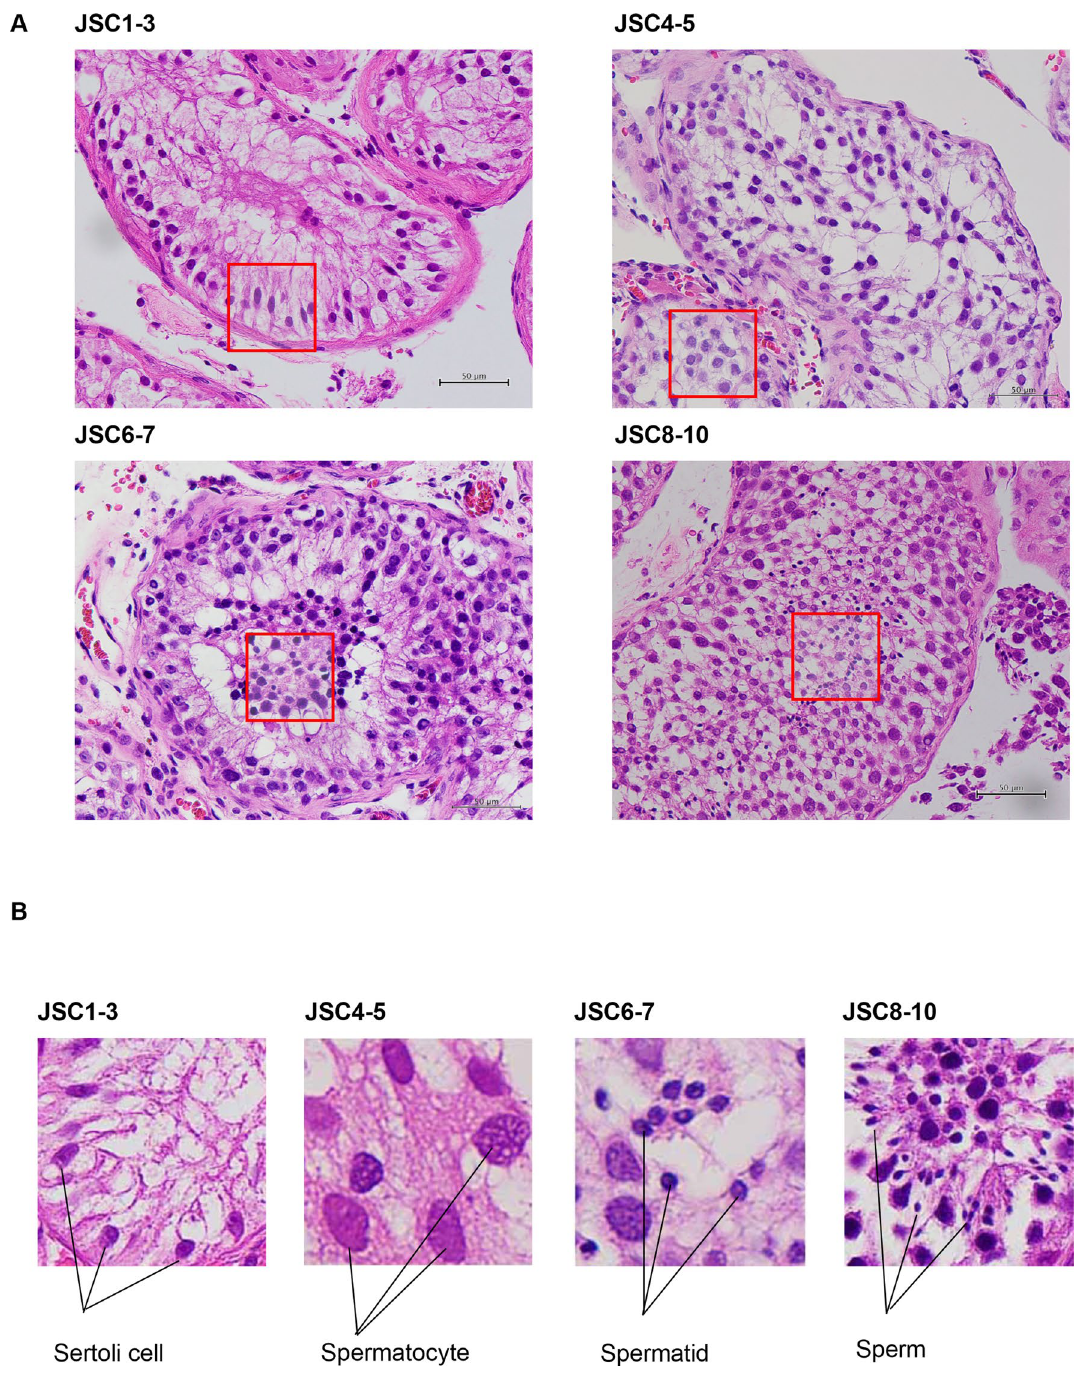
Figure 5. Expanded pathological images for JSC1-3, 4–5, 6–7, and 8–10. Red squares are cut out from pathological image (×400) to determine Johnsen score. ( B ) Characteristics of JSC 1–3, 4–5, 6–7, and